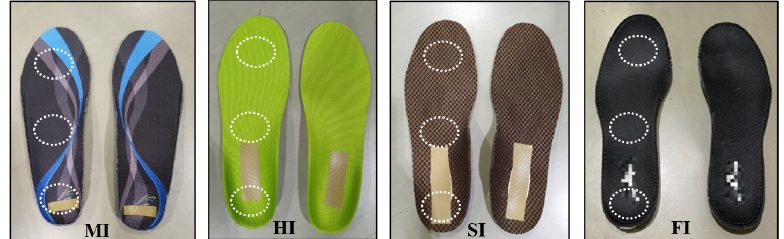
Figure 1. The medium (MI), hard (HI), and soft (SI) relative hardnesses, and the flat insole (FI). (The dotted area indicates the area of measurement for the hardness). 2.3. Experimental Protocol Participants visited the laboratory 1 day before the experimental session for familiar- ization and anthropometric measurements. Anthropometric data for each participant, including height, weight, foot type, foot length, and leg type, were collected by the same